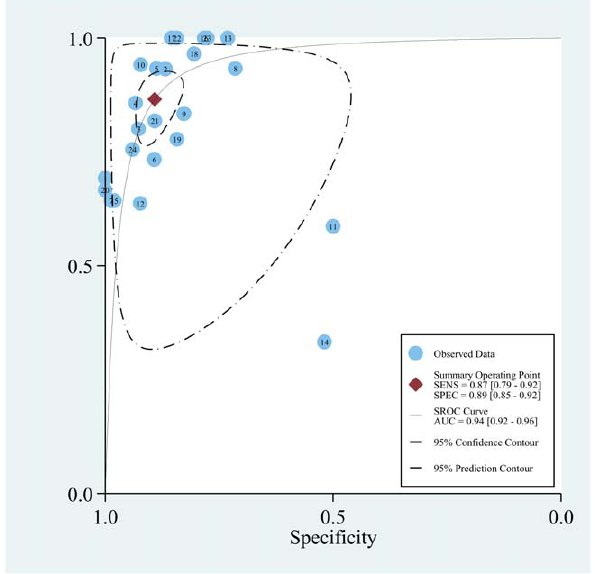
Figure 4. SROC curve for individual studies on the accuracy of diagnosis of IA using BAL-GM. (The correspondence between numbers and the studies can be found in supplement). doi:10.1371/journal.pone.0043347.g004 PLOS ONE |